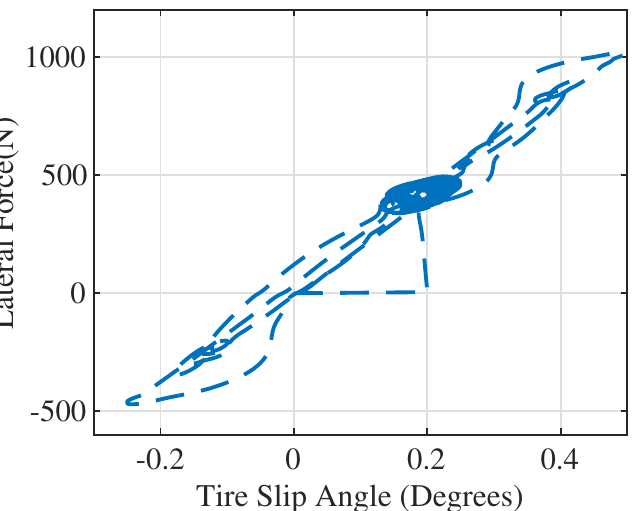
Figure 12. The behavior of lateral force with respect to the tire slip angle for v x = 60 km/h in the presence of disturbance and a variety of road conditions, µ ∈ [ 0.2–0.85 ]